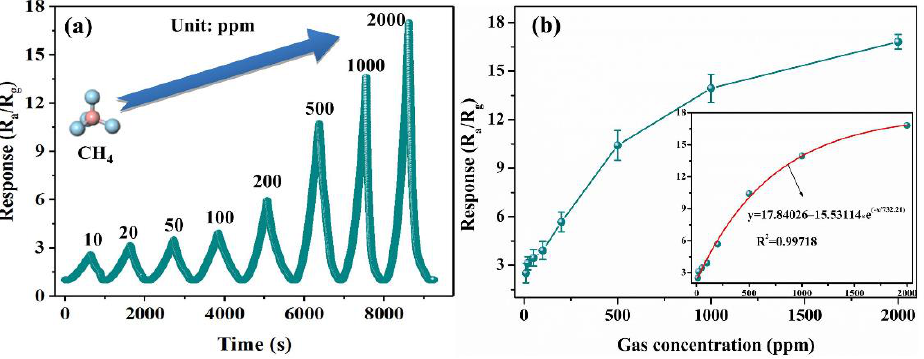
Figure 6. ( a ) Dynamic response – recovery for the 48-In 2 O 3 sensor toward CH 4 in a concentration range of 10 – 2000 ppm at 30 °C; ( b ) the response of the sensor to the concentration of CH 4 in the range of 10 – 2000 ppm (the bottom right corner inset is an exponential relationship between the gas response of the sensor and the gas concentration).